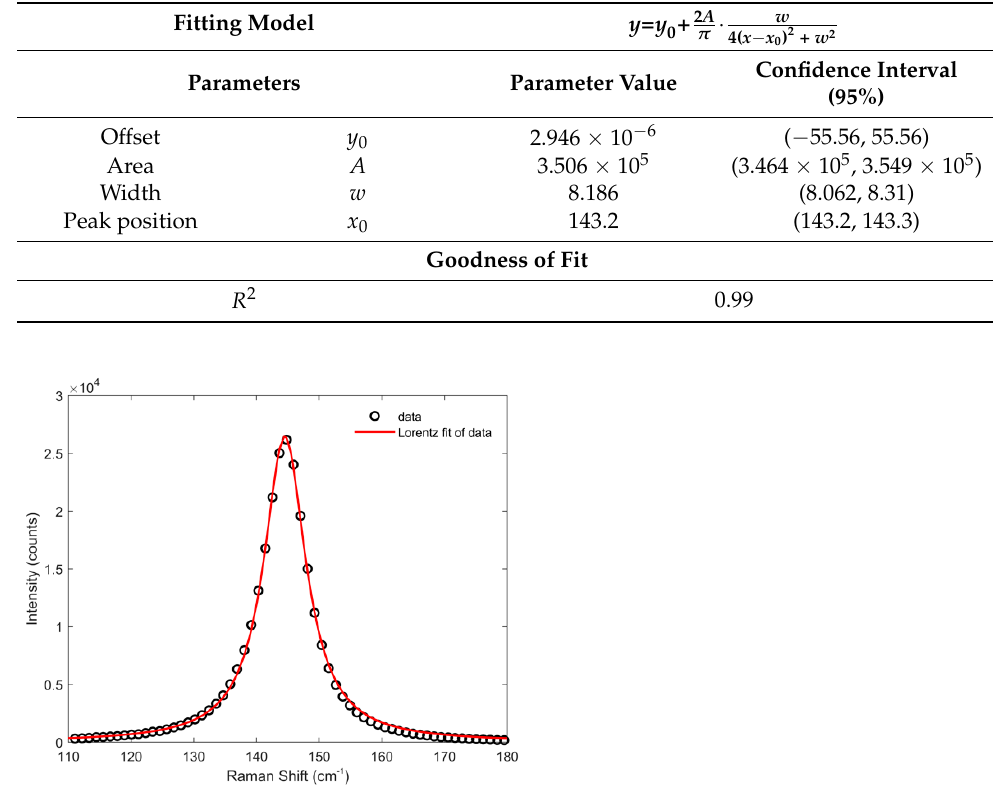
Figure A1. Experimental data collected at 𝜆 (cid:3032)(cid:3051)(cid:3030) = 514.5 nm (open circles) fitted with a Lorentzian curve (red